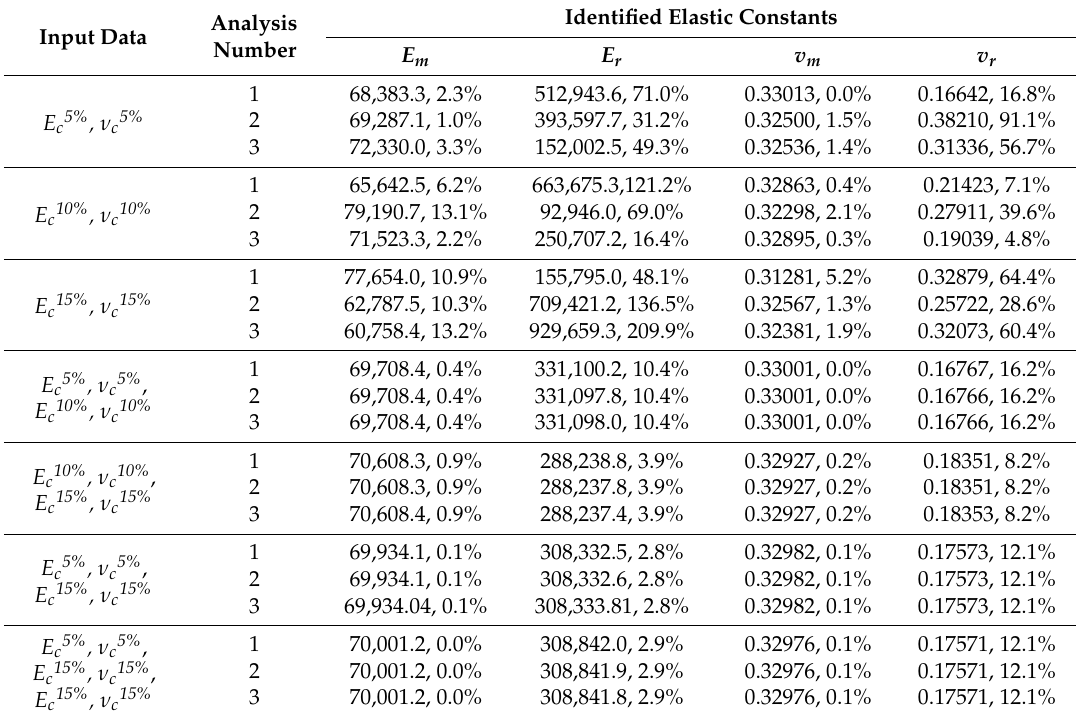
Table 3. Elastic constants of composite constituents identified by using different input data and corresponding